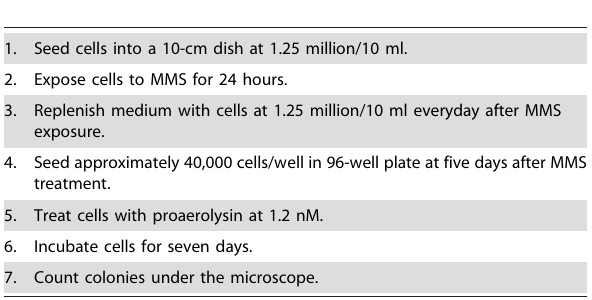
Table 4. Scheme of PIG-O mutation assay in DT40